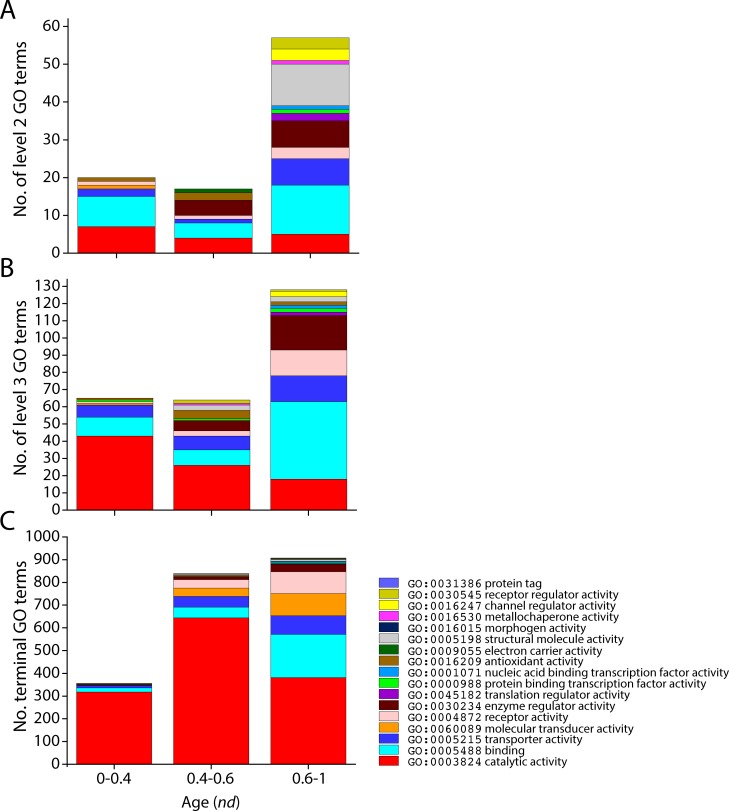
Functional disribution of GO terms at various levels in level 1 GO functional categories.(A) Histograms comparing the number of level 2 GO terms corresponding to each level 1 GO of DAGmf. (B) Histograms comparing the number of level 3 GO terms corresponding to each level 1 GO of DAGmf. (C) Histograms comparing the number of terminal GO terms corresponding to each level 1 GO of DAGmf.